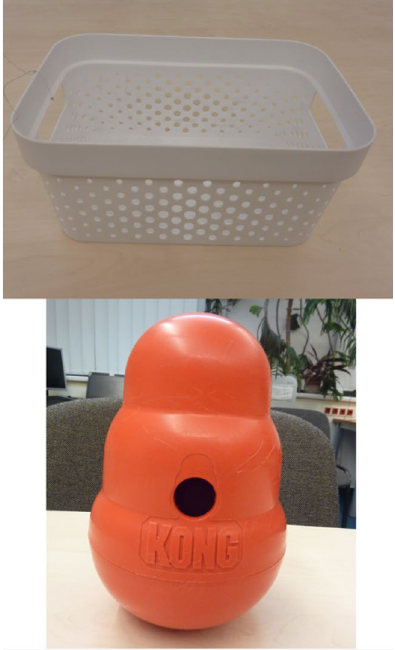
Figure 1. Objects used for testing (Box at the top, Wobbler Kong at the